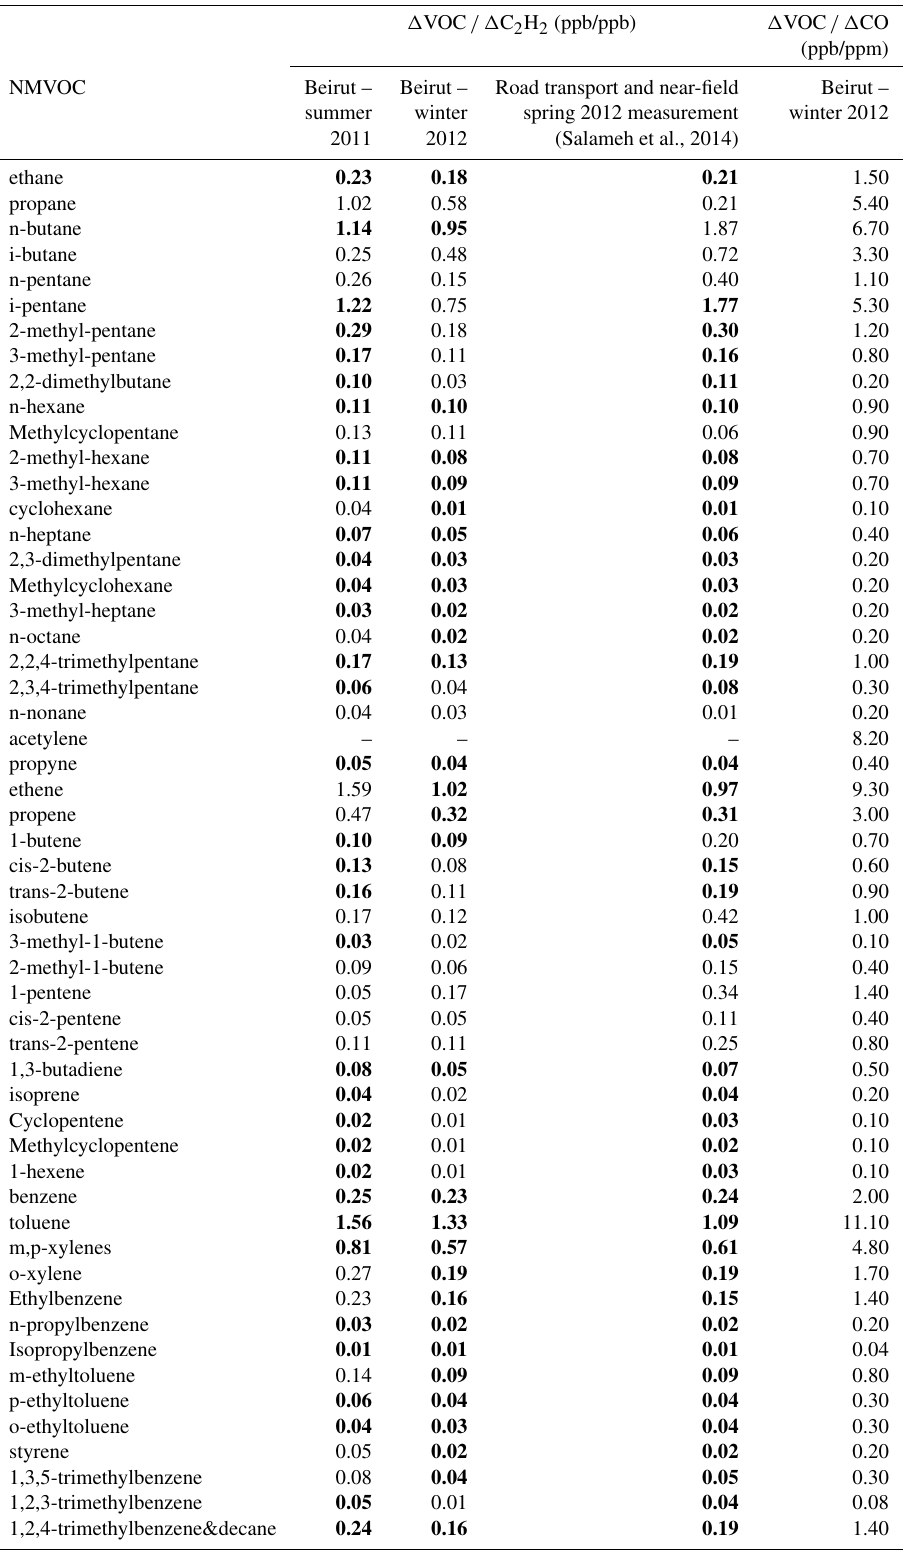
Table 2. Urban emission ratios of VOCs relative to acetylene and CO in Beirut in summer and in winter, obtained by calculating a linear regression fit to data. The ERs from road transport by near-field measurements are also reported. Bold characters indicate the similarity at ± 50% of the VOC:acetylene ER from the measurement campaigns to the one of near-field